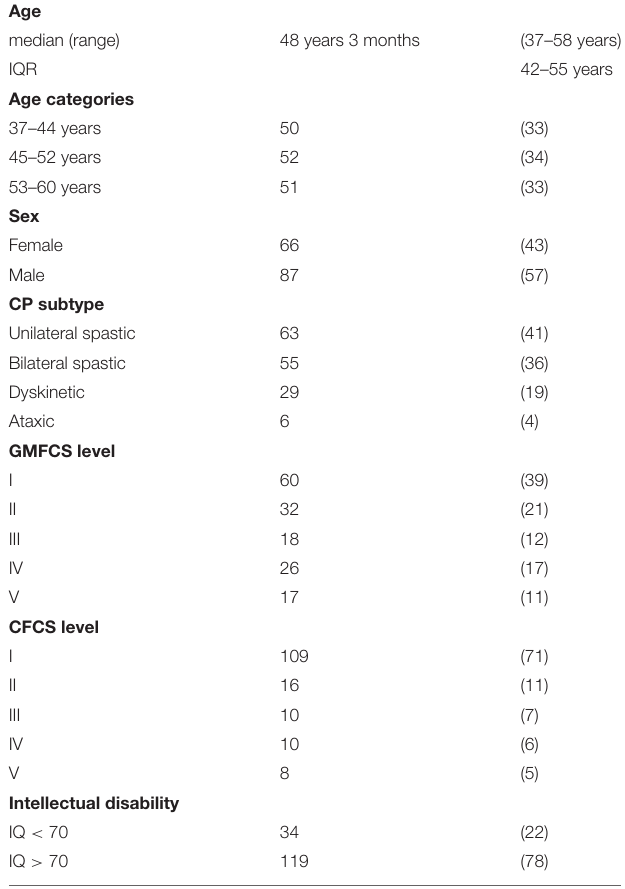
TABLE 1 | Characteristics of participants ( n =